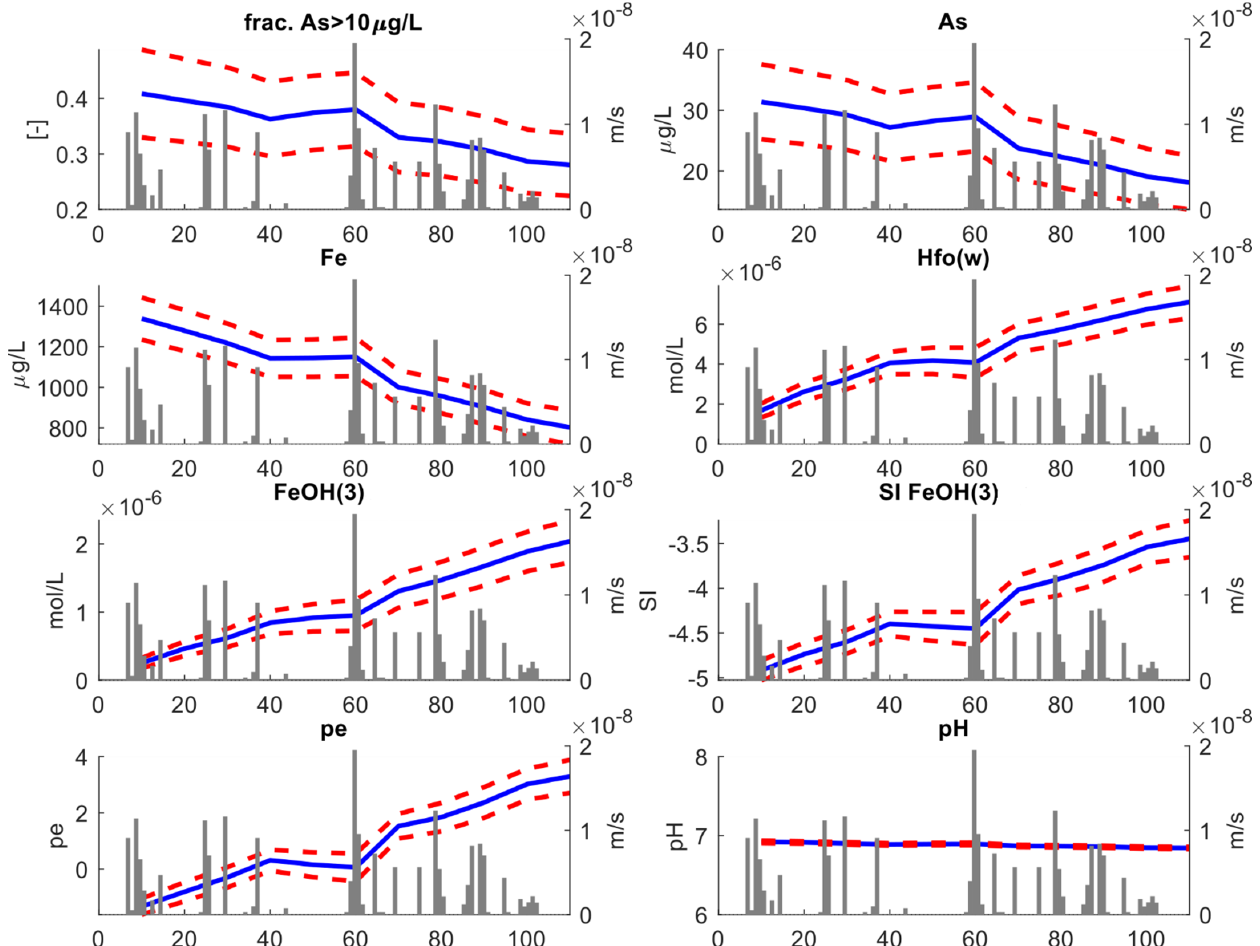
Figure 9. Key results of the stochastic transport analysis. This figure refers to the “shallow depth” analysis. For each variable, the blue lines reproduce the ensemble mean obtained from averaging over the 100 stochastic simulations, while the red dotted lines represent the 95% (±2 σ ) uncertainty envelop. The gray bars represent the recharge rates (ms − 1 ).